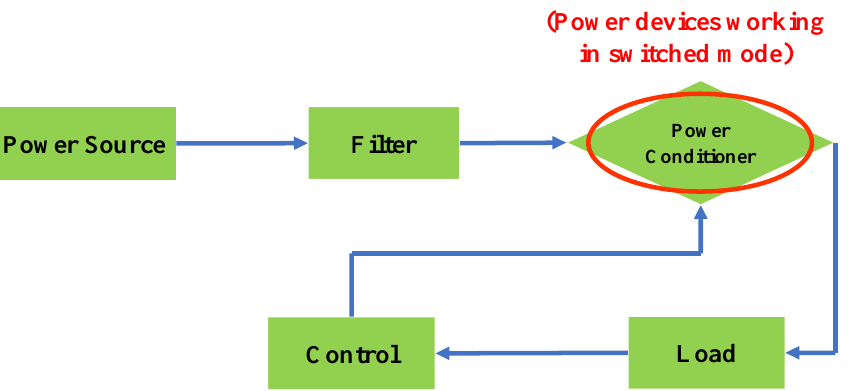
Figure 2. Components of a power electronic system and power semiconductor devices in power conditioners.